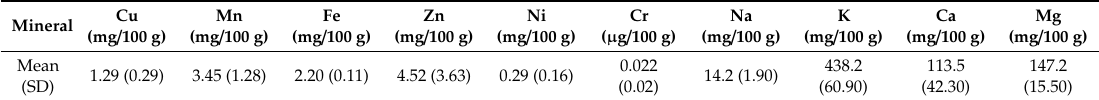
Table 3. Mineral composition of walnuts from Serbia.